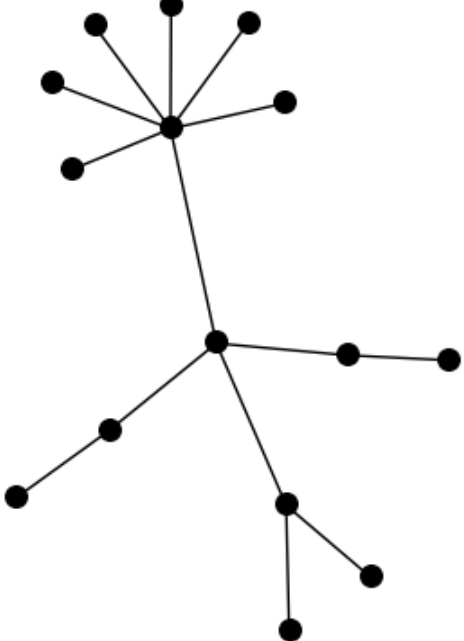
Figure 1. The construction for c 1 = 3, c 2 = 7, and q = 6.